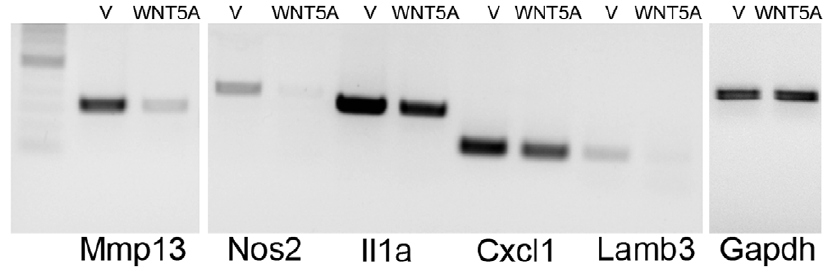
Table 3. Cell movement genes regulated in Wnt5a cells indentified in both microarray and RNA-Seq.